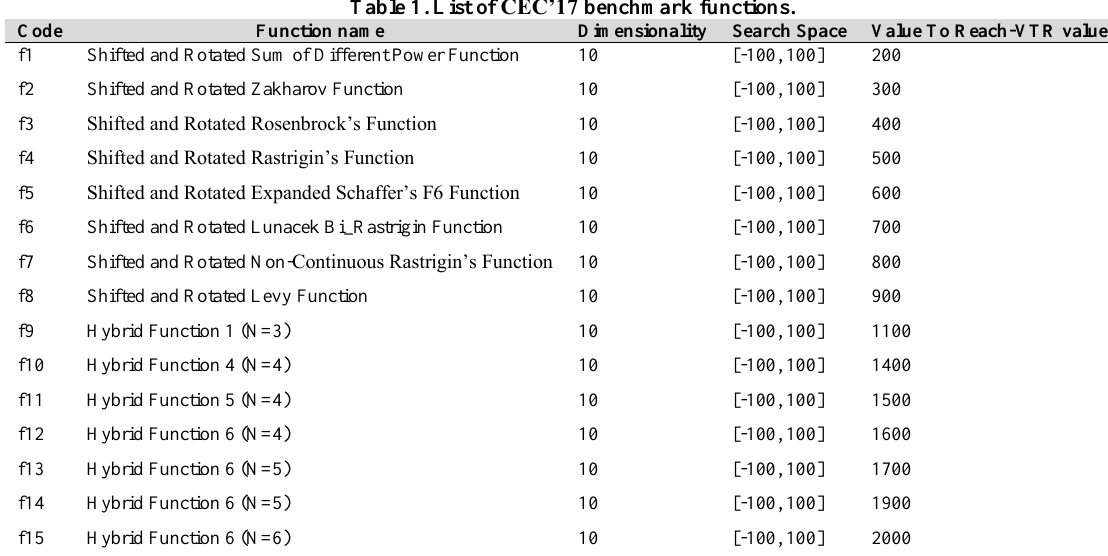
Table 1. List of CEC’17 benchmark functions.